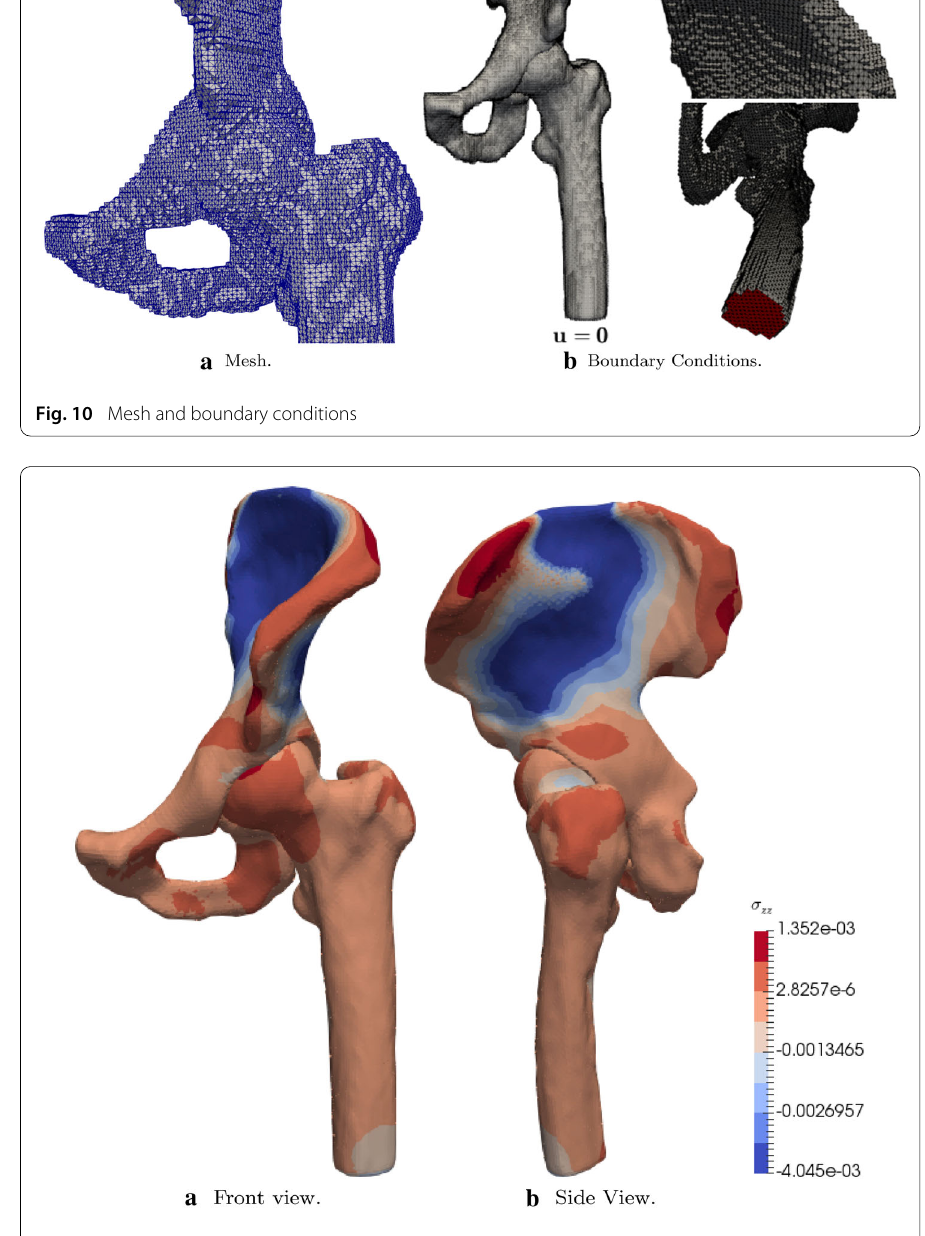
Fig. 11 Stress component σ zz in the hip and femur bone in front view ( a ) and side view ( b